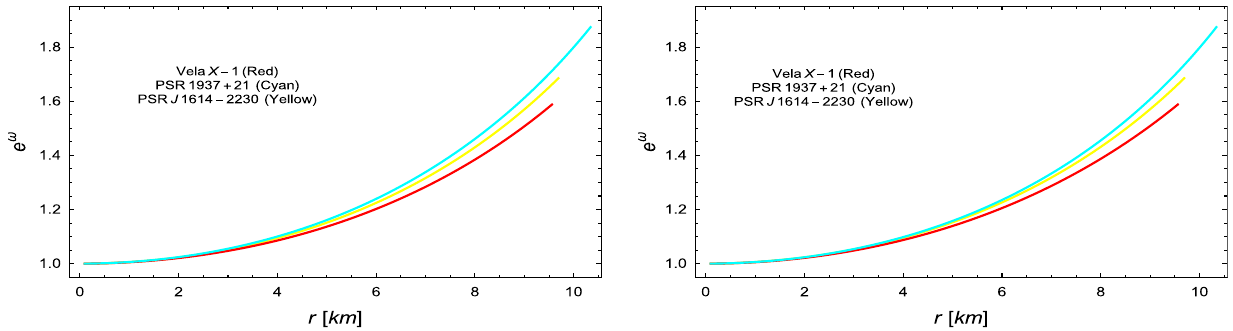
Fig. 1 Shows the variations of deformation function h ( r ) (left panel for 1st solution and right panel for 2nd solution) with respect to r